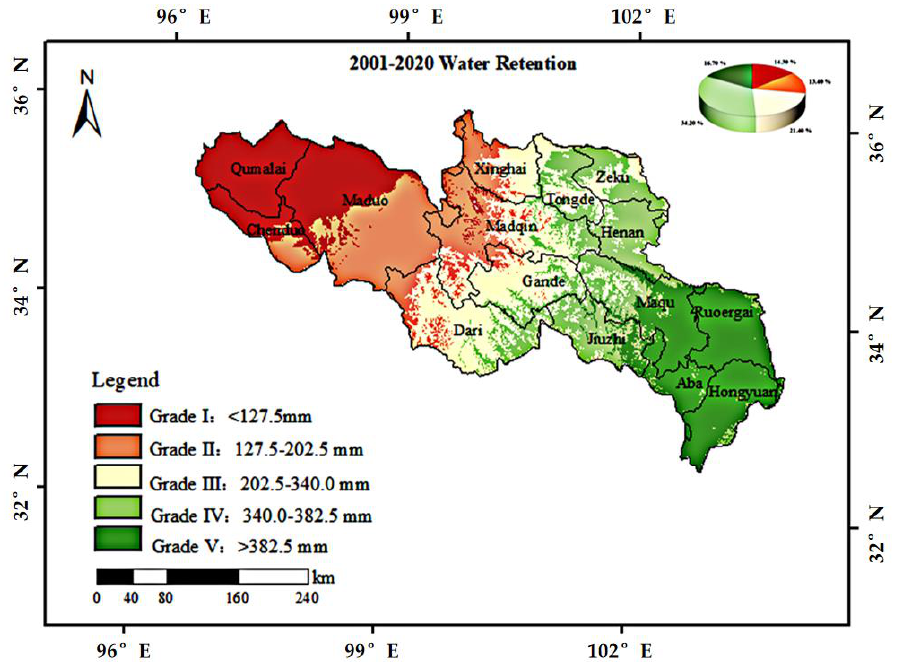
Figure 6. Spatial division of water retention in the HYR (the pie chart shows the proportion of water retention distribution ranges).